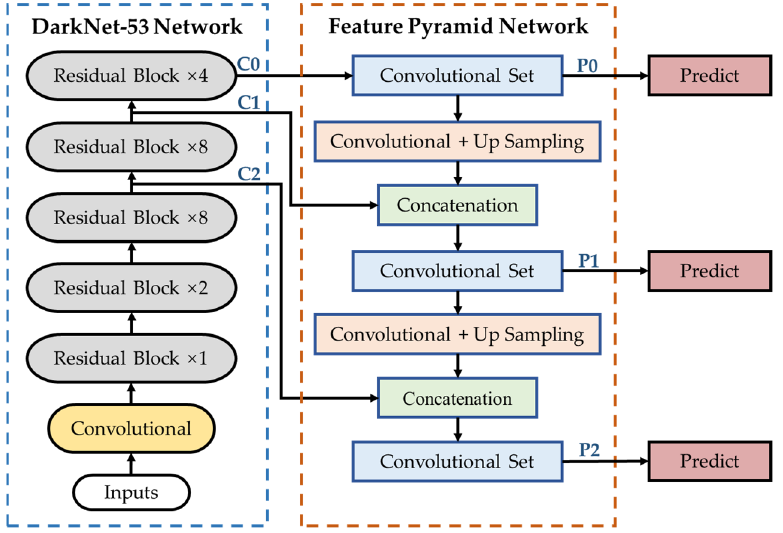
Figure 1. The structure of YOLOV3.